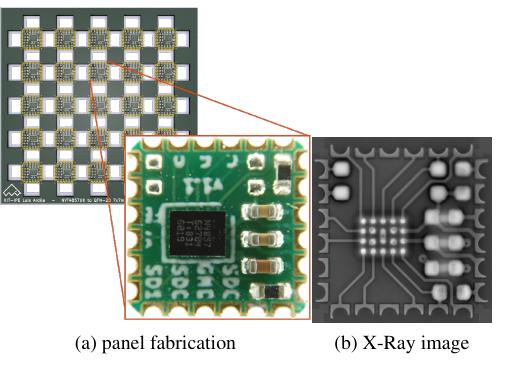
Figure 4: microSD controller module